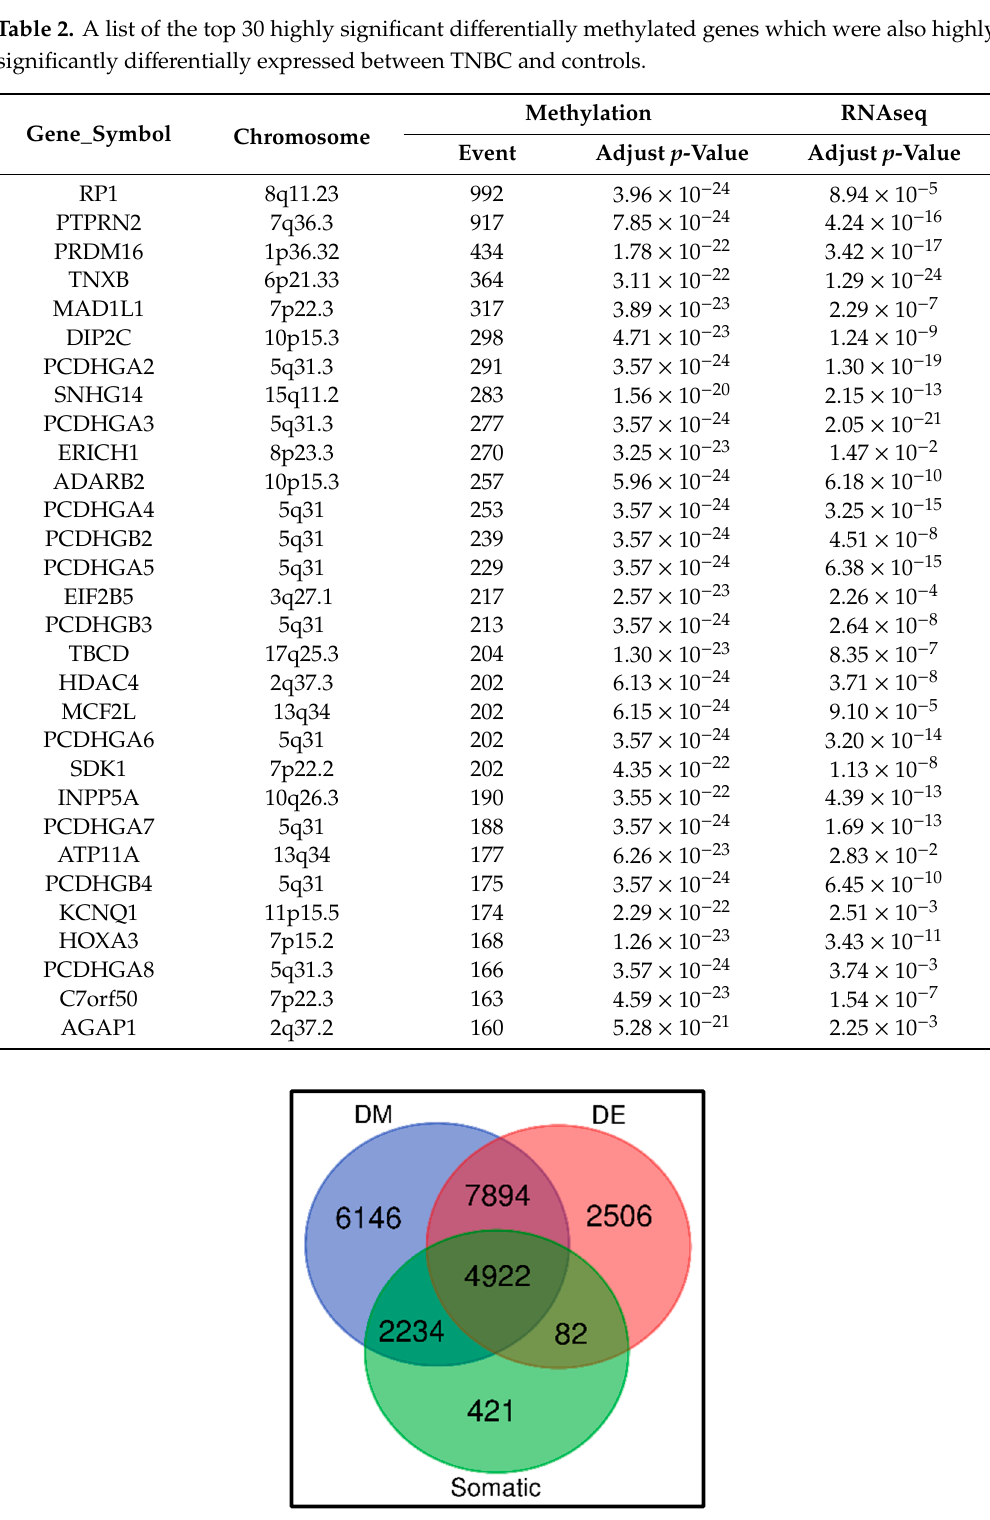
Figure 3. Three-way Venn diagram showing the number of transcriptionally, somatically and epigenomically altered genes associated with TNBC. DM indicates DNA methylation, DE denotes differentially expressed, and Somatic indicates somatic mutated genes.